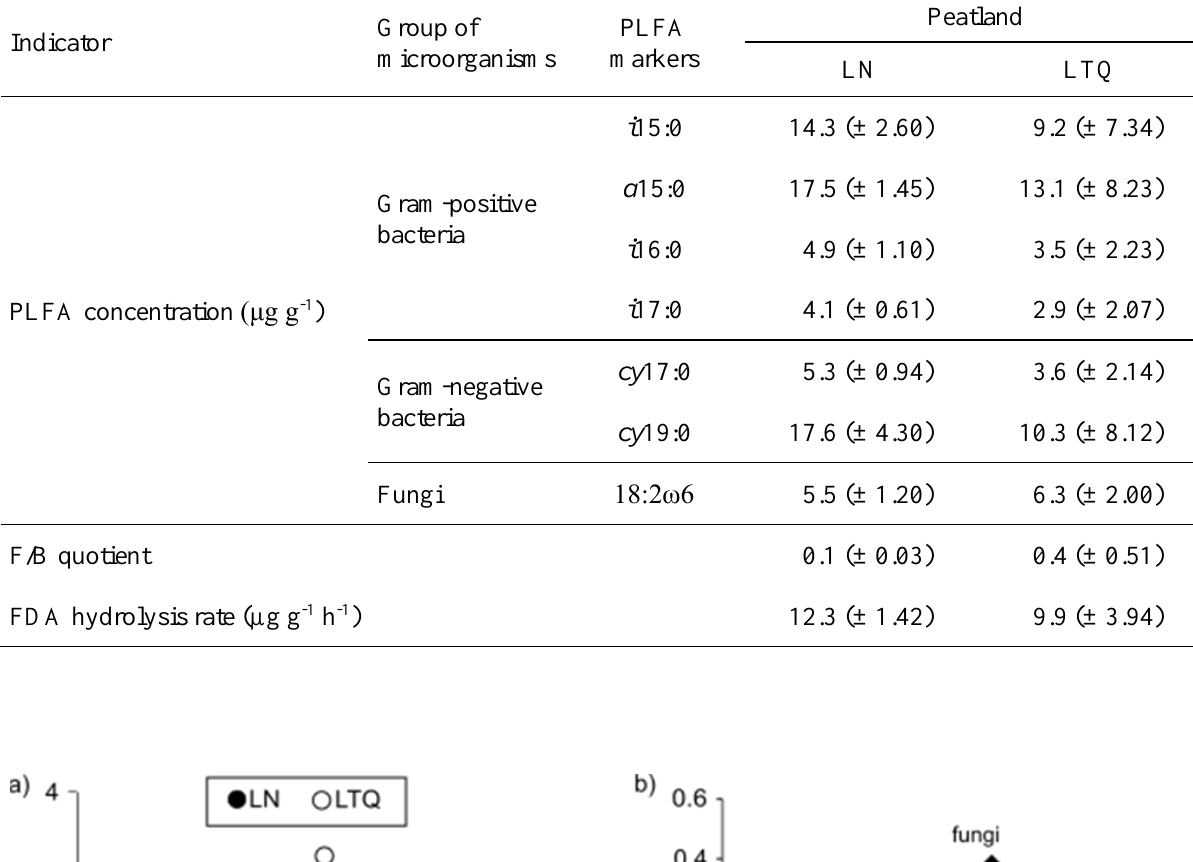
Table 2. PLFA (phospholipid fatty acid) profiles and concentrations, F/B (fungi/bacteria) quotients and FDA (fluorescein di-acetate) hydrolysis rates (mean values ± standard deviation, n = 5; dry soil basis) in soil from two peatlands in the Argentinean Puna, as indicators for the active microbial communities. LN: peatland associated with Laguna Negra, LTQ: peatland associated with Laguna Tres Quebradas. None of the microbial variables differed significantly between peatlands (p > 0.05).